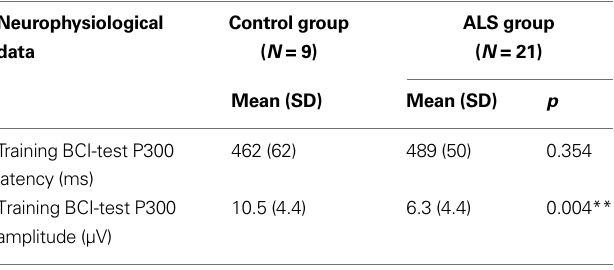
Table 6 | Results of the training BCI-test P300 latency and amplitude in Control and ALS; all measures refer to the channel PZ.